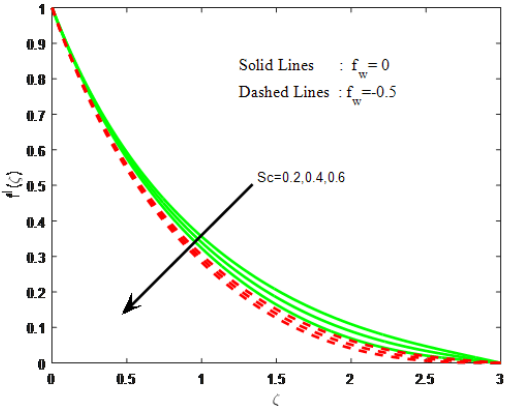
Fig. 14: The effect of chemical reaction parameter ( K l ) on tempera- ture field